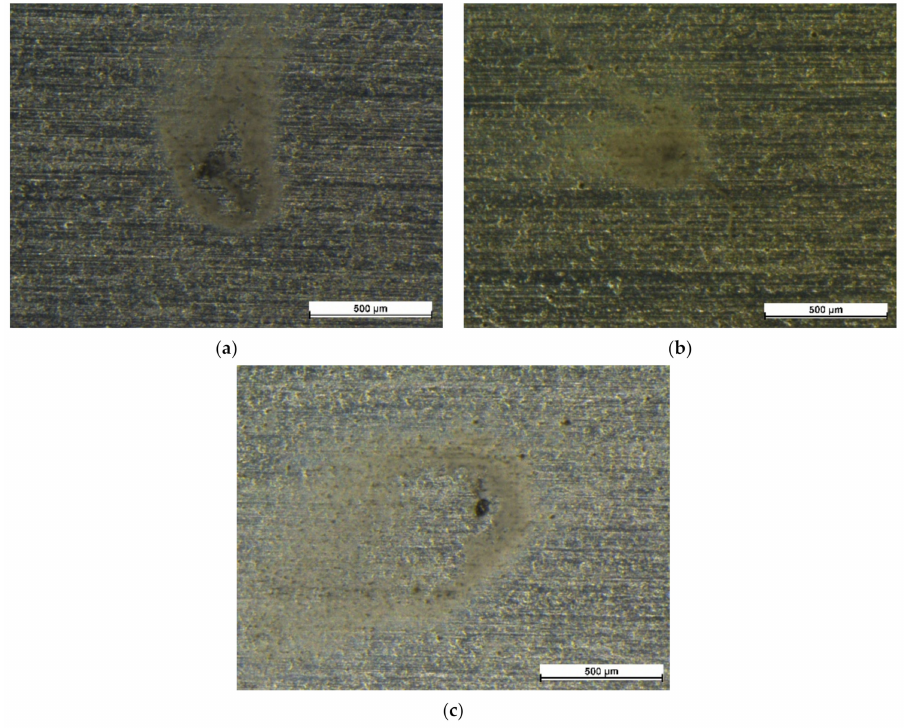
Figure 4. Corrosion products of sample X ( a ), sample A ( b ) and sample B ( c ), respectively, after 24 h of exposure in a salt spray